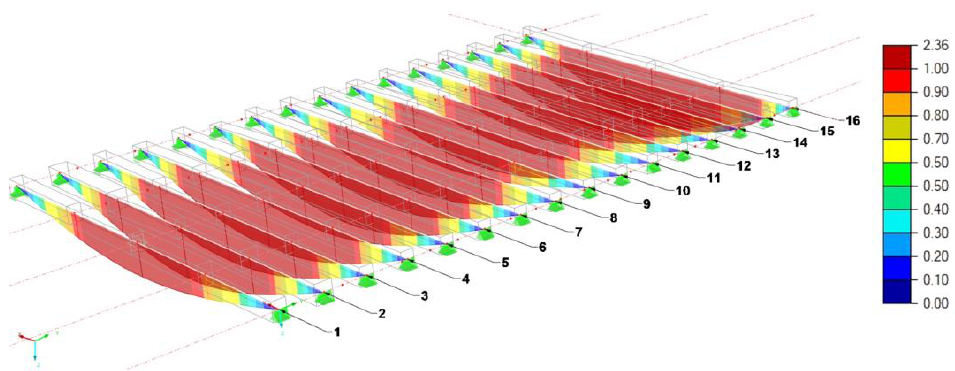
Figure 24. SLS diagram of the different beams of the floor (% of the maximum capacity). The sections marked in red among the beams indicate reaching 100% of the structural capacity.